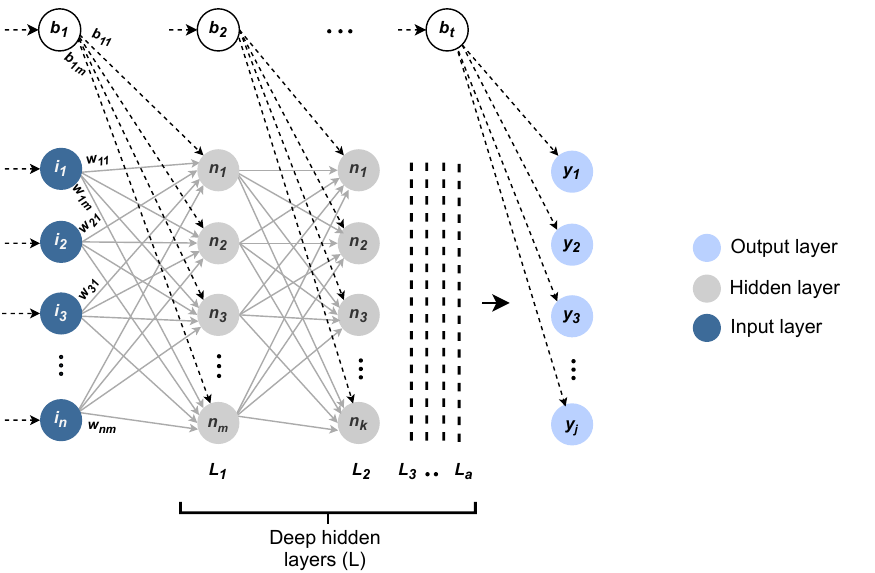
Figure 2. The anatomy of a deep neural network model, a is the number of hidden